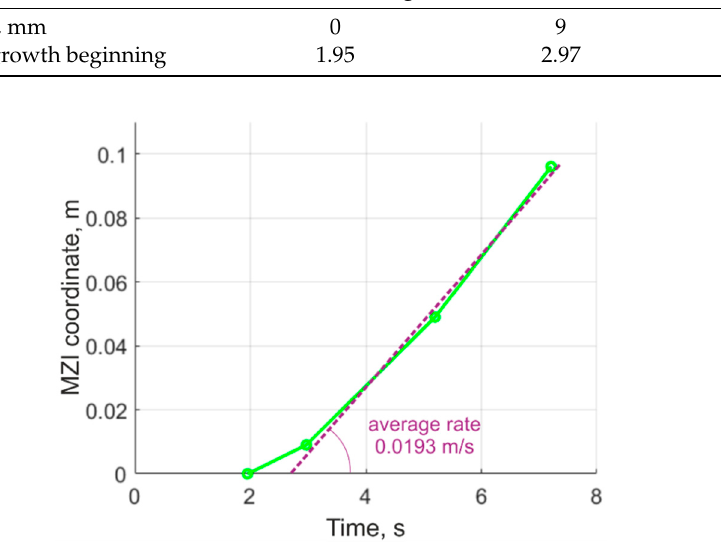
Figure 10. Graph of the combustion surface movement.